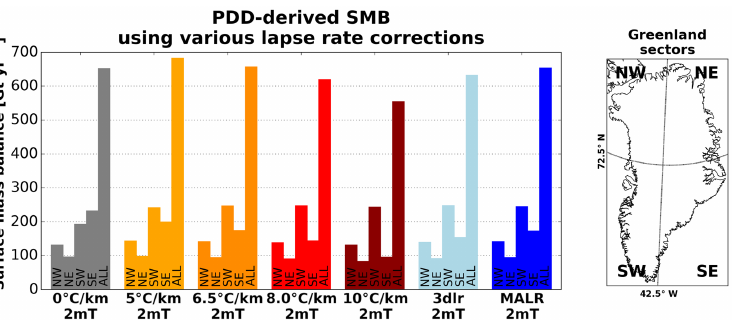
Figure 6. Sensitivity of the PDD-derived SMB to the applied temperature lapse rate correction (to low-resolution climate). The bars show the integrated SMB over the GrIS and its regional contributions. 0 ◦ Ckm − 1 refers to the uncorrected temperature, 5 to 10 ◦ Ckm − 1 represent spatially uniform temperature lapse rates, 3dlr is the 3-D lapse rate derived from the vertical NorESM temperature column, and MALR is the moist adiabatic lapse rate calculated from the thermodynamic state of the NorESM surface air